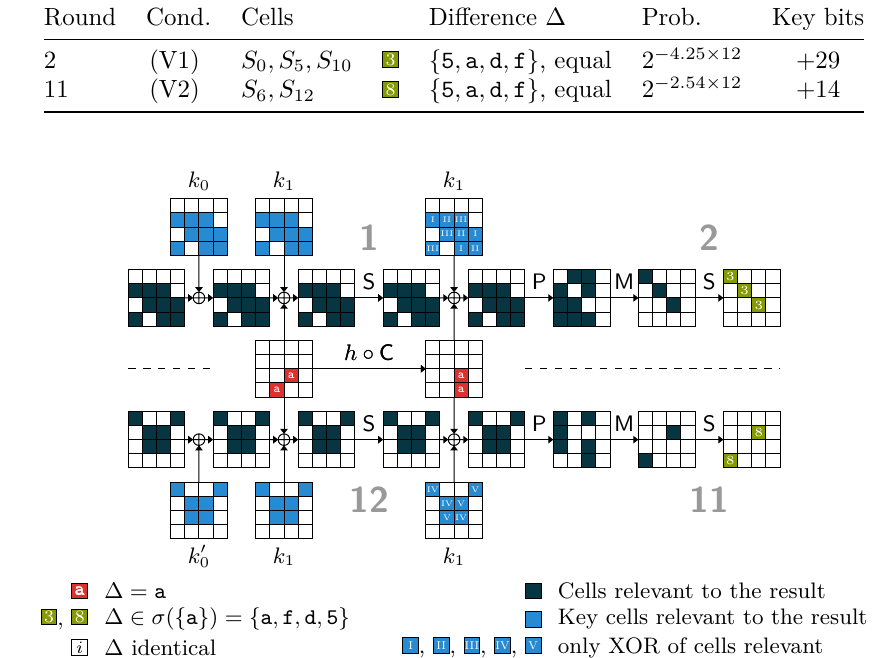
Figure 4: Cells influencing the 29-bit (top) and 14-bit (bottom) key-recovery